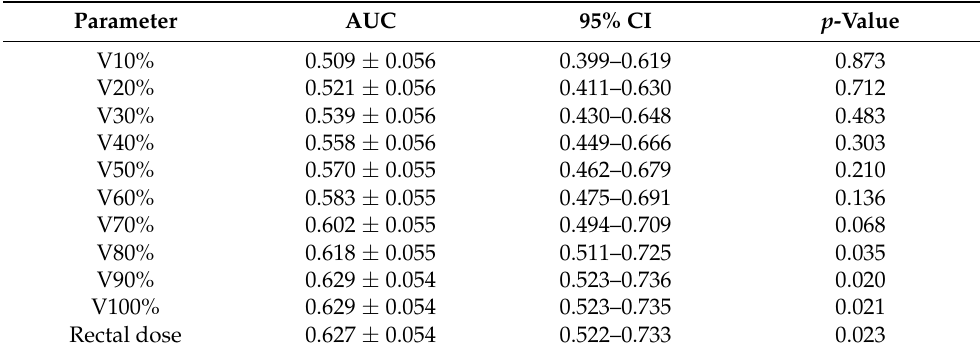
Table 3. ROC curve for Grade 2–3 diarrhea.